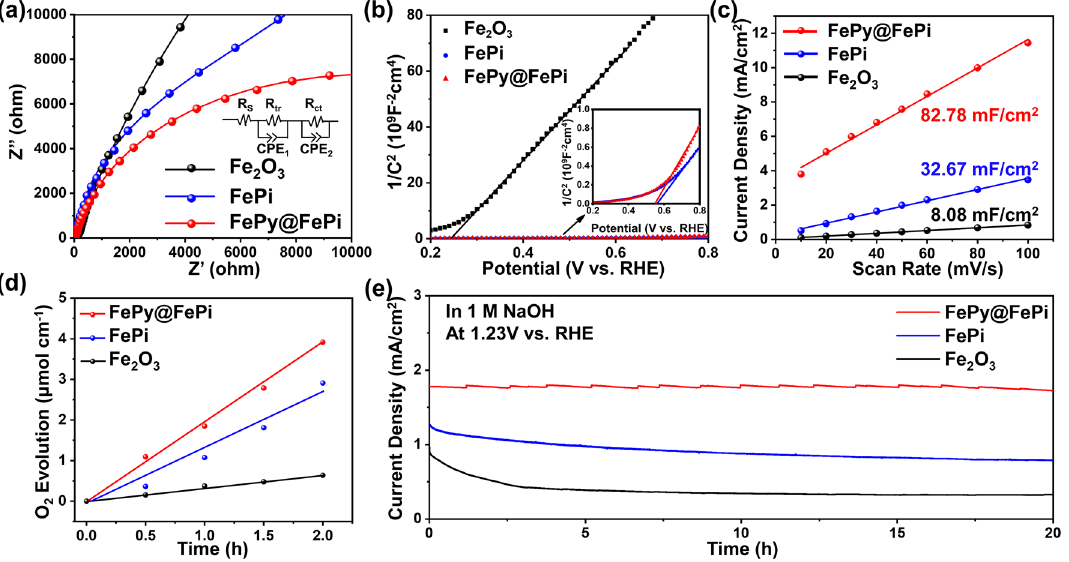
Fig. 6 a Nyquist plots from EIS characterization under 1 sun illumination in 1 M NaOH electrolyte at 1.23 V versus RHE. b Mott–Schottky plots of fabricated photoanodes under dark conditions in 1 M NaOH electrolyte. c Electrochemical double‑layer capacity ( C dl ) of FePy@FePi, FePi, and Fe 2 O 3 . d O 2 evolution‑time plot of fabricated photoanodes. e J-t curves of the fabricated photoanodes under 1 sun illumination condi‑ tions in 1 M NaOH electrolyte at 1.23 V versus RHE for a 20 h stability